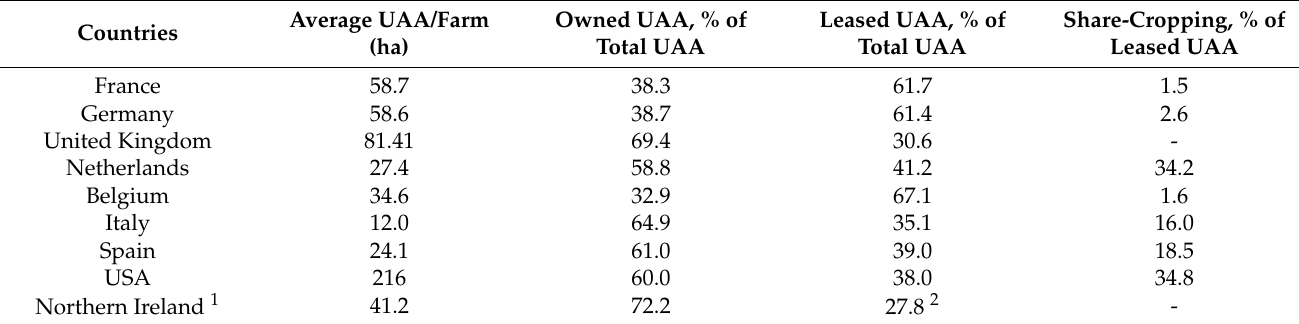
Table 1. Characteristics of farmland structure in some selected countries.